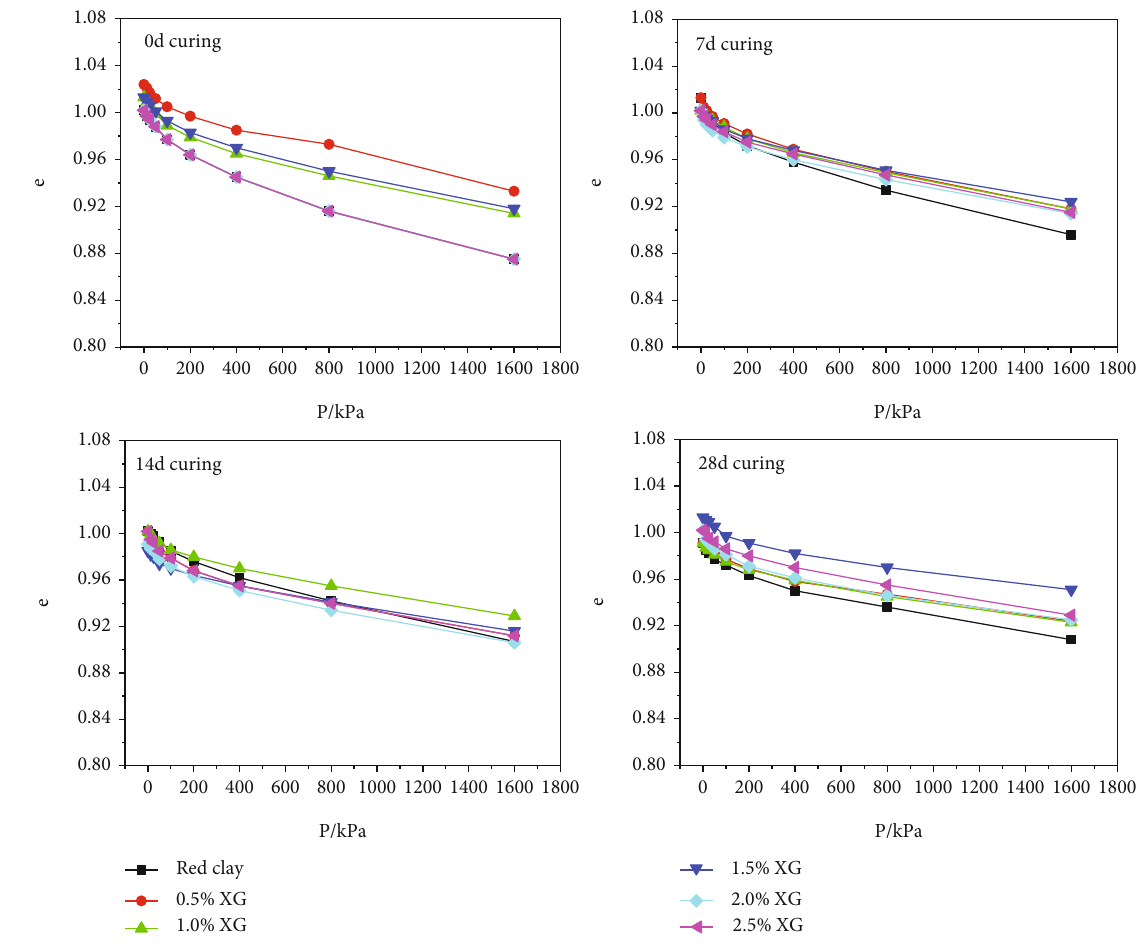
Figure 4: Relationship of